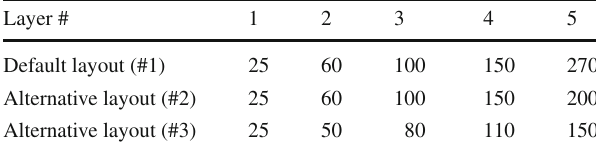
Table 1 Radial distances (in mm) of the first five layers from the beam line for the three inner-tracker layouts considered in this study Layer